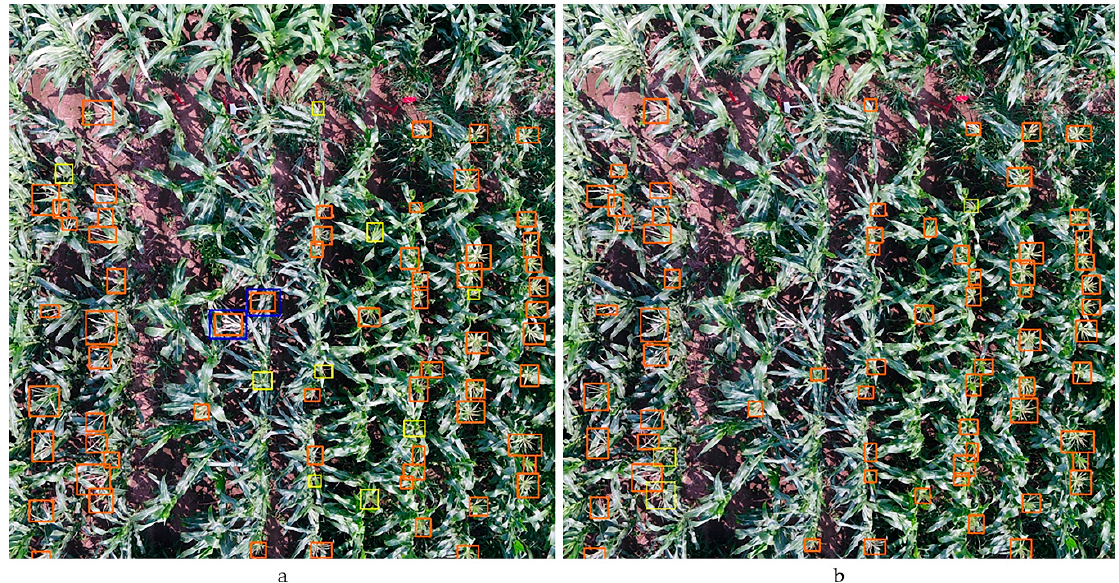
Figure 9. Maize tassels identified by the default anchor size [128 2 ,256 2 ,512 2 ] ( a ), and the modified anchor size [85 2 , 128 2 , 256 2 ] ( b ) with ResNet101 in Faster R-CNN. The red boxes, yellow boxes, and blue boxes represent the original prediction, absent detection, and incorrect detection, respectively.